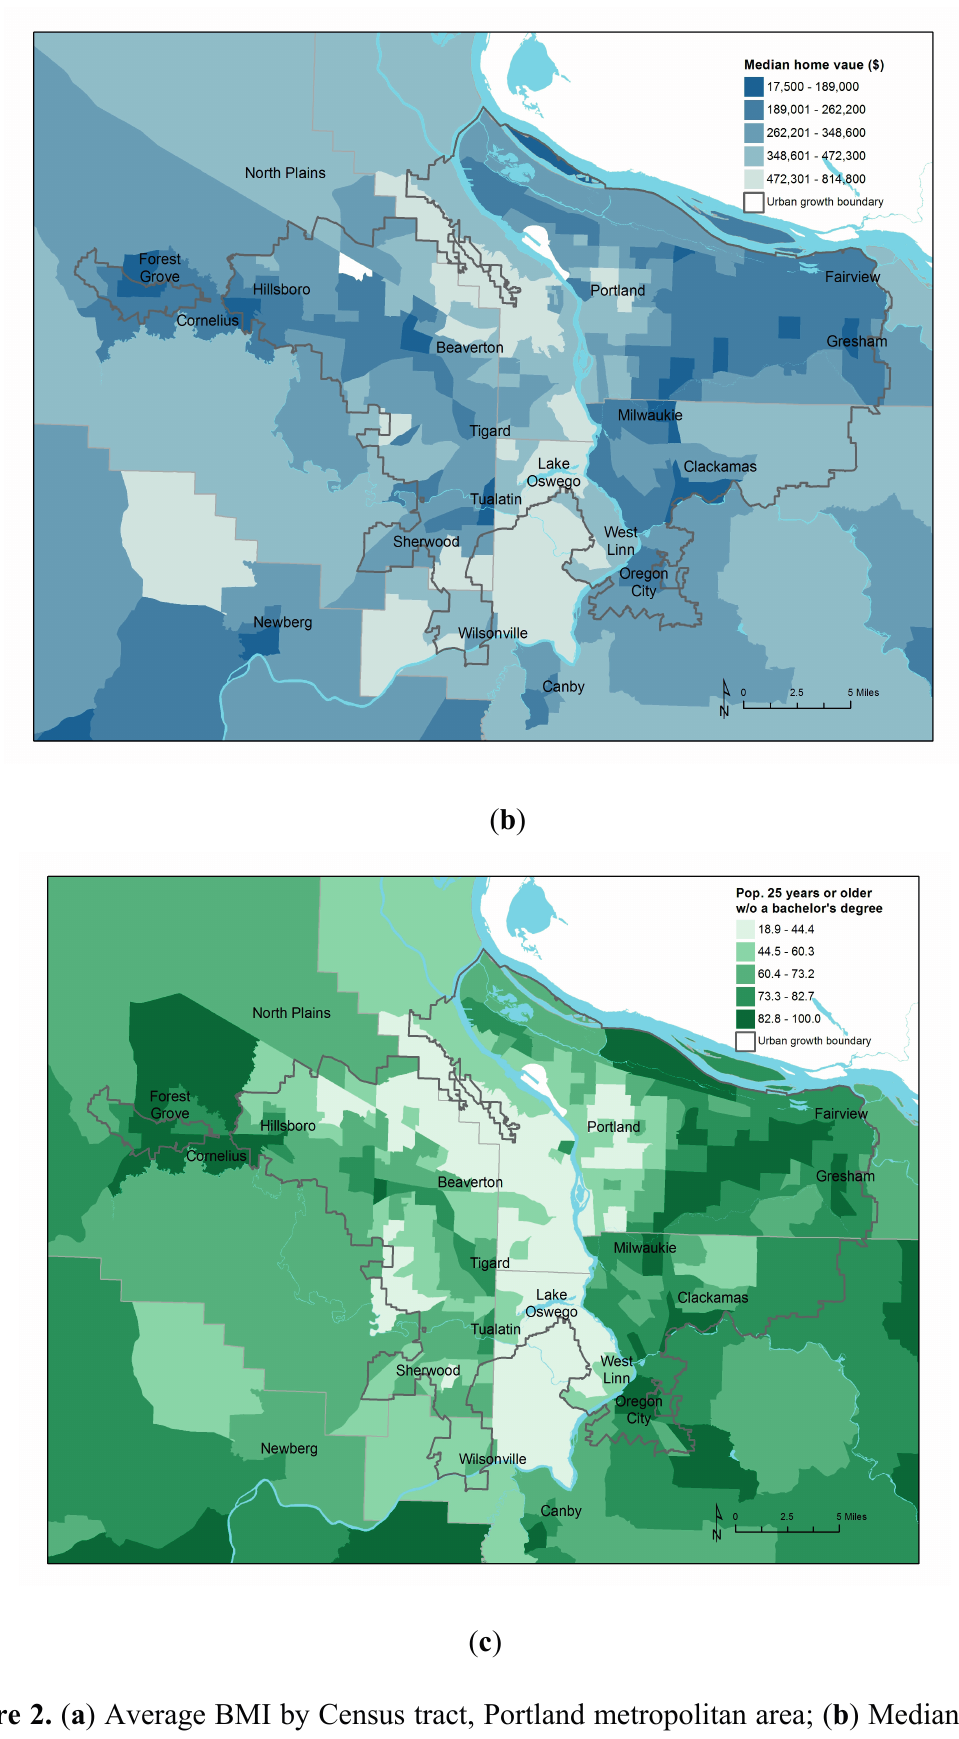
Figure 2. ( a ) Average BMI by Census tract, Portland metropolitan area; ( b ) Median home value; ( c ) Percent of adults 25 years and older without a college